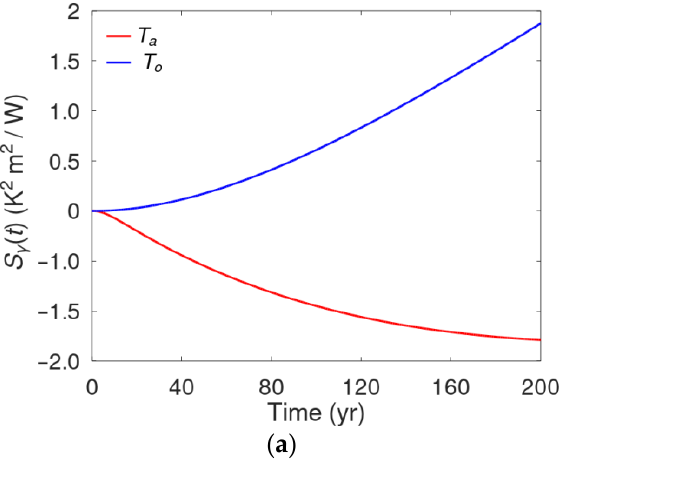
Figure 8. Sensitivities of mean surface temperature (red line) and mean deep ocean temperature (blue line) with respect to parameter 𝛾 , calculated for linear forcing: ( a ) over time interval of 0–200 years, ( b ) over time interval of 0–2000 years.